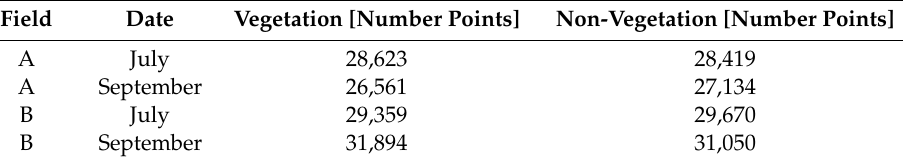
Table 2. Sample size of points per plot, UAV flight date and class (vegetation and non-vegetation).